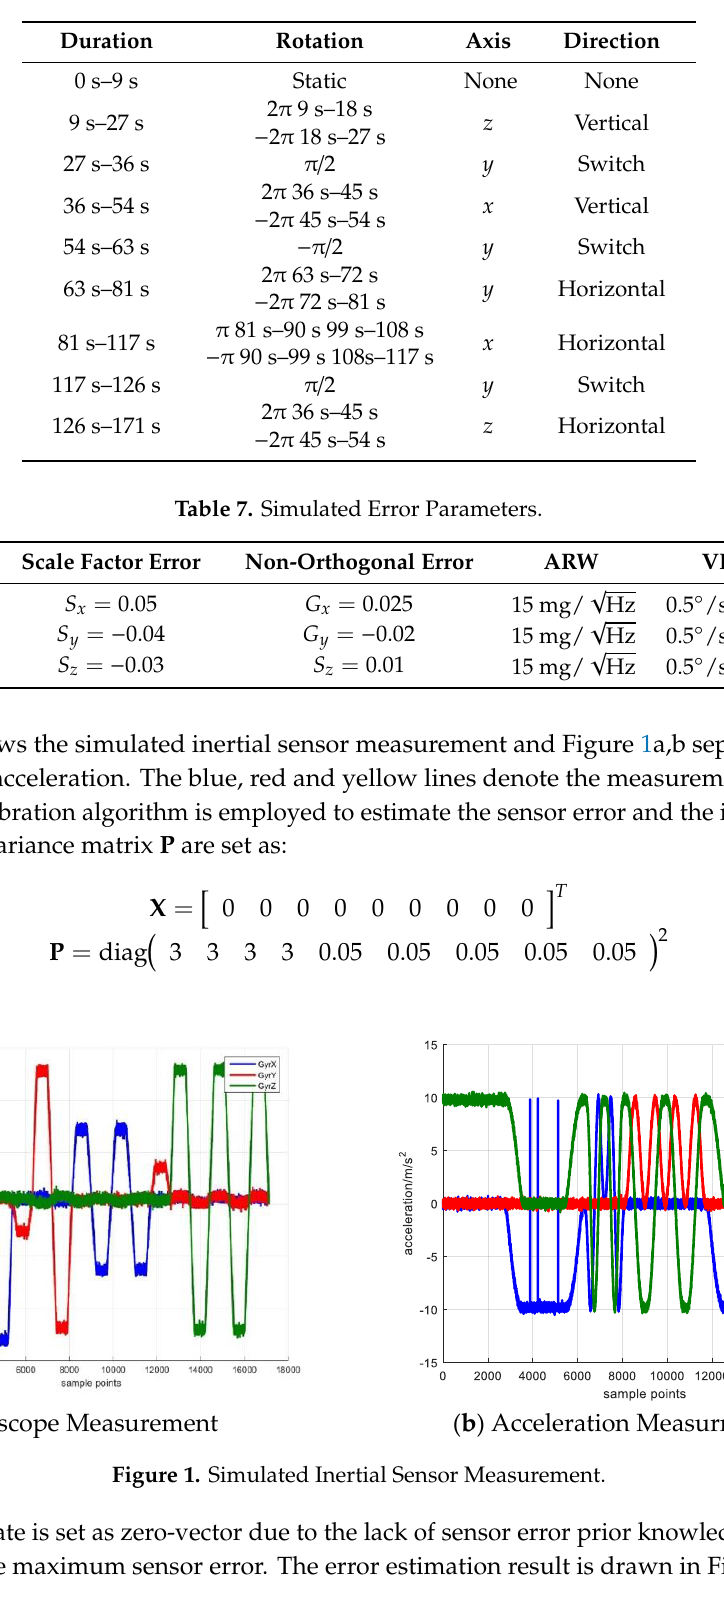
( b )Non-orthogonal error Figure 2. Sensor Error Calibration Result. Figure 2 shows the sensor error estimation result, Figure 2a denotes the scale factor error and Figure 2b shows the non-orthogonal error result. The blue, red and yellow line denote the error of x , y and z axes. Figure 3 shows the elements of P matrix, Figure 3a,b denote the elements corresponding to the scale factor error and the non-orthogonal error; Figure 3c,d denote the elements corresponding to attitude error and heading error. The reason for investigating the elements of covariance matrix P is that if its diagonal element experiences a large decrease from its initial value, the corresponding state becomes observable and its observability is large [20]. As shown in Figure 3, because the IMU keeps static in the first 10 s, the state vector is not observable, and the diagonal element of P matrix does not change. Starting from 10 s, the IMU rotates with respect to z -axis, the 𝐺 𝑥 , 𝐺 𝑦 converge to the reasonable value and their corresponding P matrix elements decrease dramatically. When the IMU rotates along x axis vertically beginning from 40 s, the 𝐺 𝑧 begins to converge and its corresponding P matrix element decreases. The non-orthogonal